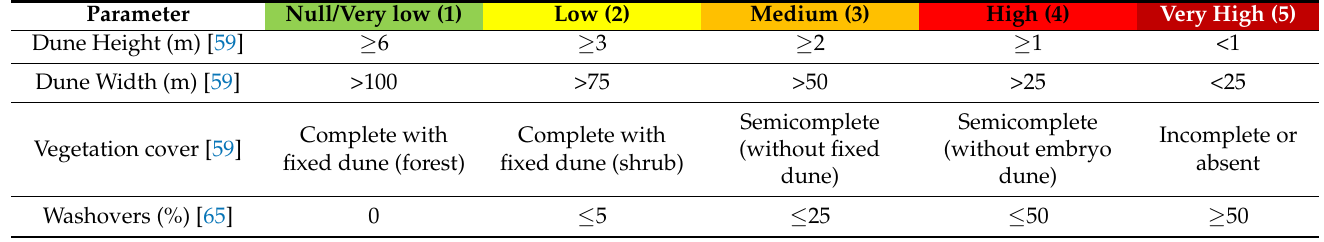
Table 4. “Dunes” parameters